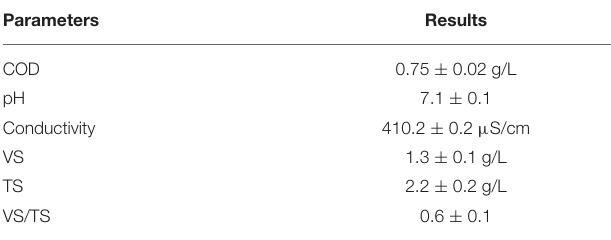
TABLE 1 | Physico-chemical characteristics of the activated sludge digestate inoculum.